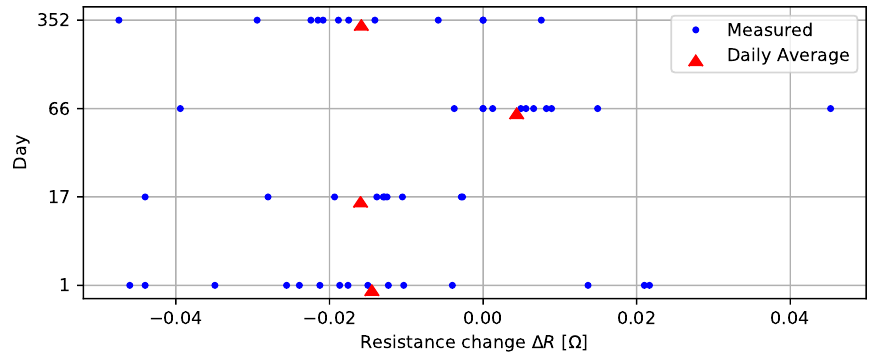
Figure 12. Trace resistance over time.